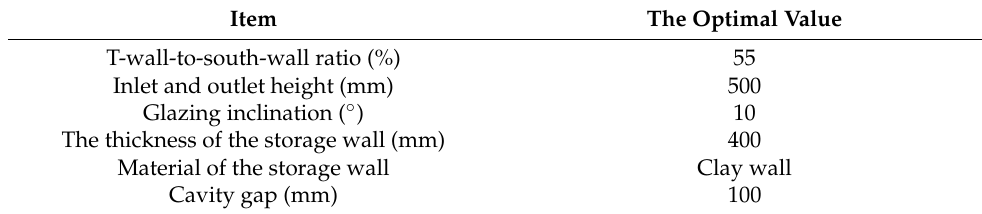
Table 1. Optimal size of the T-wall structure [21].